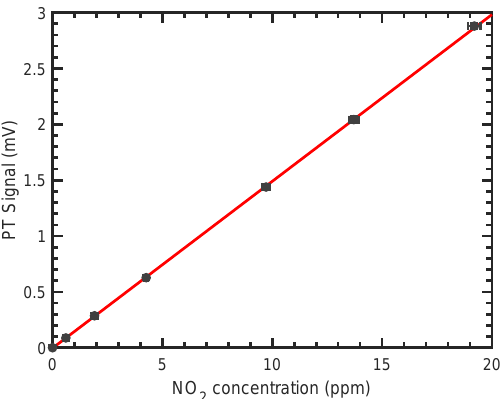
Figure 6. Each data point was averaged for approximately 40 values, i.e., 40 s. All signals are background- corrected with respect to their phase. The sensitivity was determined to be ( 0.149 ± 0.002 ) mV ppm − 1 from a weighted linear regression. The coefficient of determination for the fit is R 2 = 0.999.